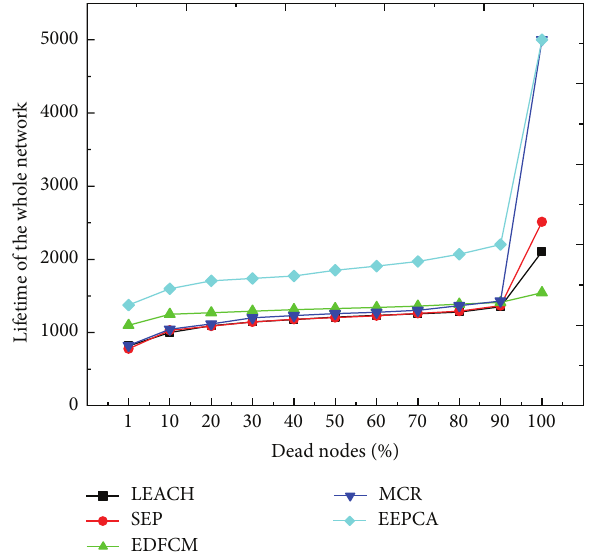
Figure 14: Lifetime of the whole network.